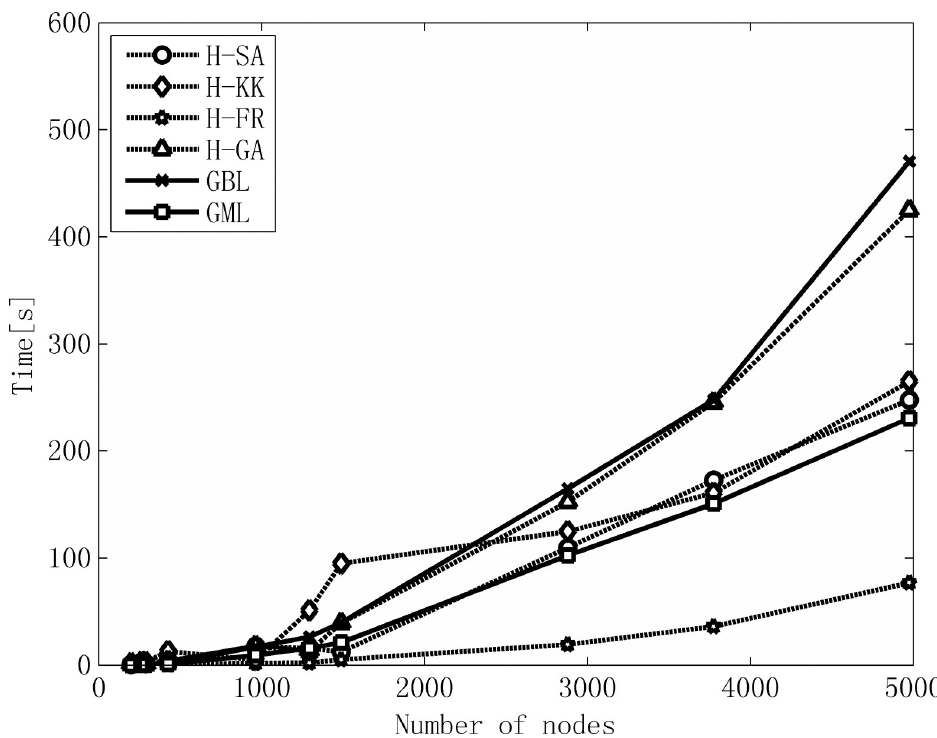
Fig 4. The comparison of computation time. The computation time for each test network was averaged on 10 runs on a Dell laptop with an Intel Core i3-2330M processor.